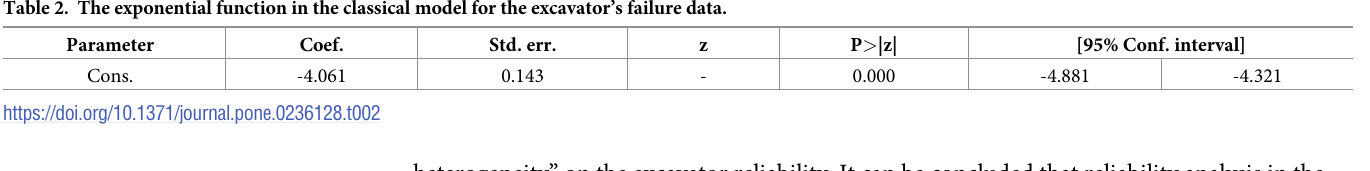
frailty model tends to the left side of the proposed algorithm in Fig 3.